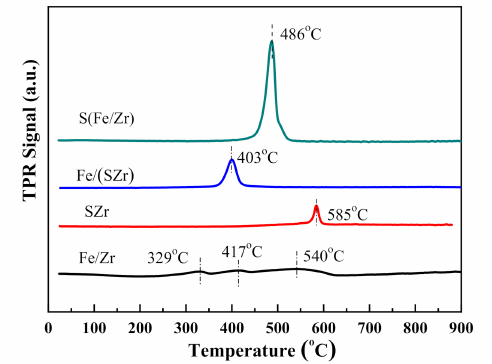
Figure 5. H 2 –temperature-programmed reduction (H 2 -TPR) patterns of di ff erent iron-based catalysts.